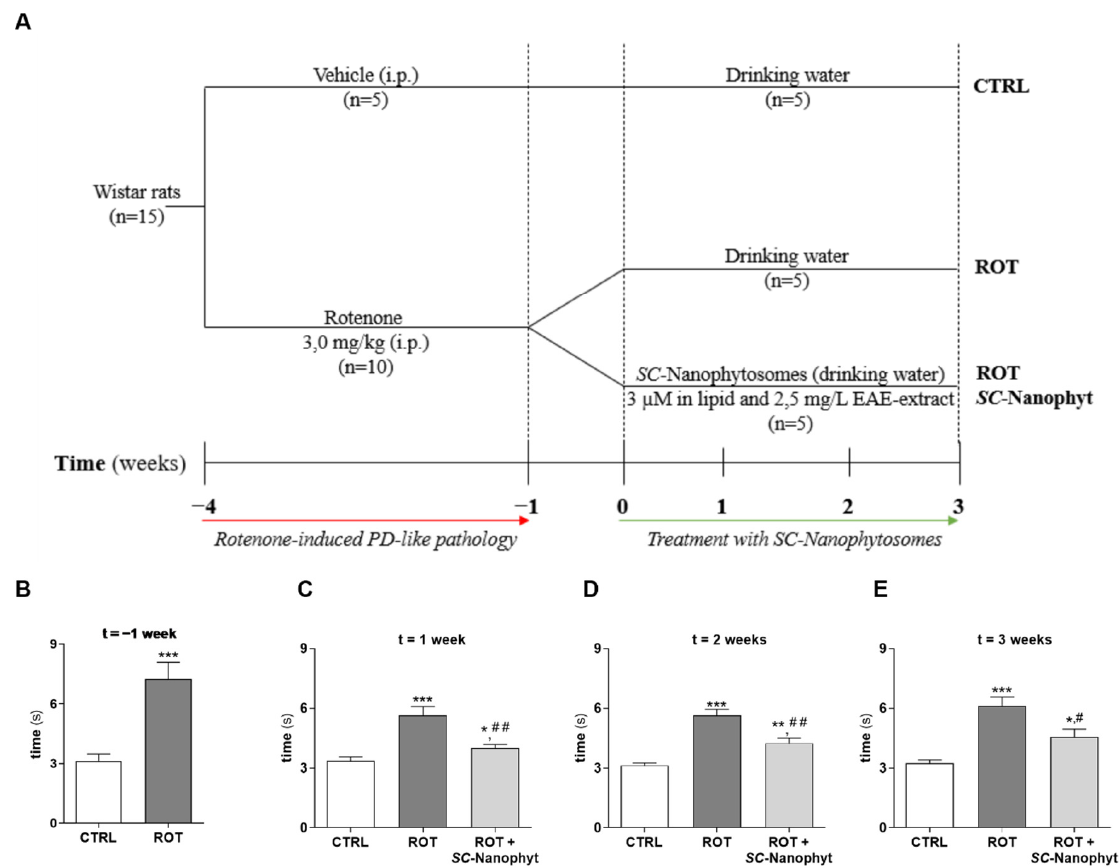
Figure 2. ( A ) Schematic representation of the experimental procedure. Rotenone-induced PD-like pathology for three weeks, one week break, and then three weeks of SC -Nanophytosomes treatment (3 µM in phospholipid and 2.5 mg/L in EAE-extract). ( B – E ) Average times from assessment of motor balance and coordination in the rats using the beam walking test. ( B ) Average times for rats crossing the 6 mm beam after three weeks of pre-treatment with rotenone (3.0 mg/kg, i.p.) and control. Effect of treatment with SC -Nanophytosomes on the first week ( C ), after two weeks ( D ), and three weeks ( E ) in average times for crossing the 6 mm beam in CTRL, ROT, and ROT + SC -Nanophyt groups. Error bars represent SEM for n = 5 independent experiments using five animals in each one. *, **, *** Significantly different from CTRL group, with p ≤ 0.05, p < 0.01 and p < 0.001, respectively. # , ## Significantly different from ROT group with p ≤ 0.05 and p < 0.01.